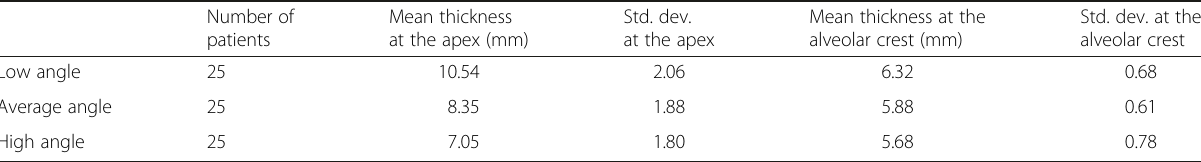
Table 1 Summary statistics of patient population at the mandibular alveolar apex and the alveolar crest